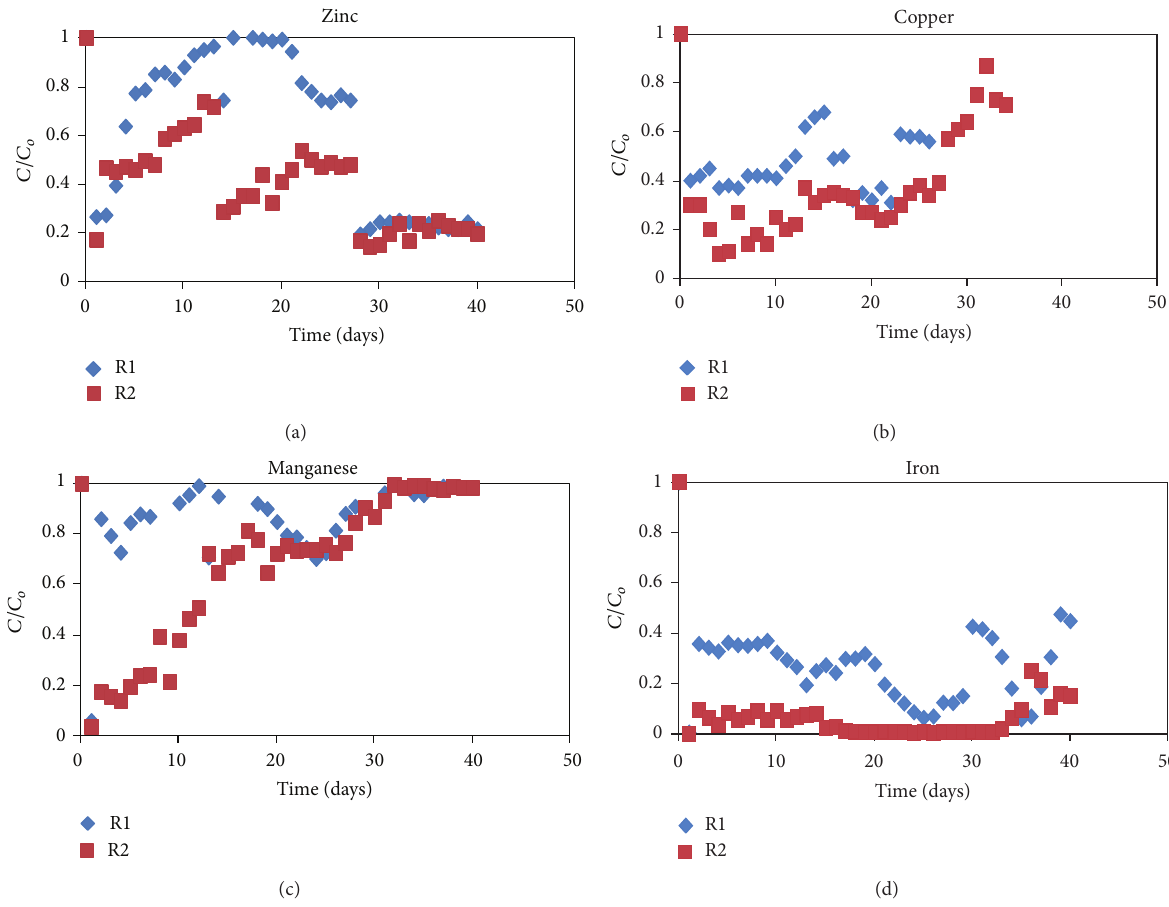
Figure 2: Biosorption kinetics of Zn, Cu, Mn, and Fe in a continuous system, using Issatchenkia orientalis and Candida tropicalis yeasts immobilized in clinoptilolite zeolite.